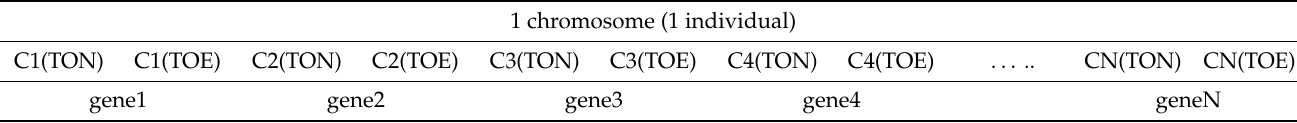
Table 2. Representation of the clustering module solution. 1 chromosome (1 individual)